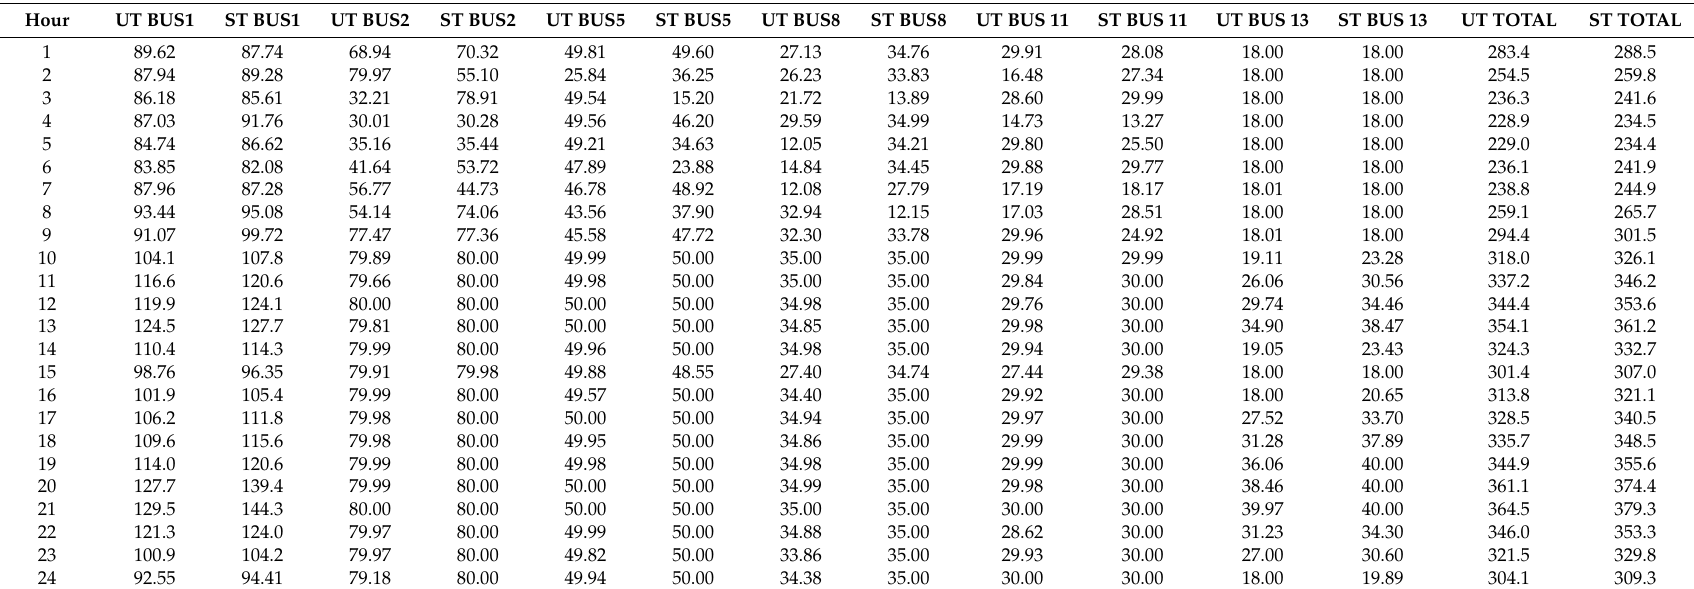
Table 3. Hourly optimal purchase power for the unified and separate trading in the day-ahead market